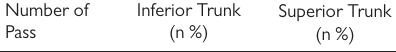
Table 2. Stent Retriever Placement for the Division of Middle Cerebral Artery Number of Pass